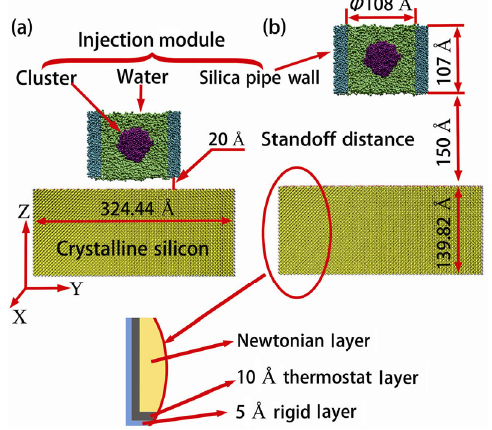
Fig. 1 Simulation model of an AWJ. (a) Standoff distance = 20 Å; (b) standoff distance = 150